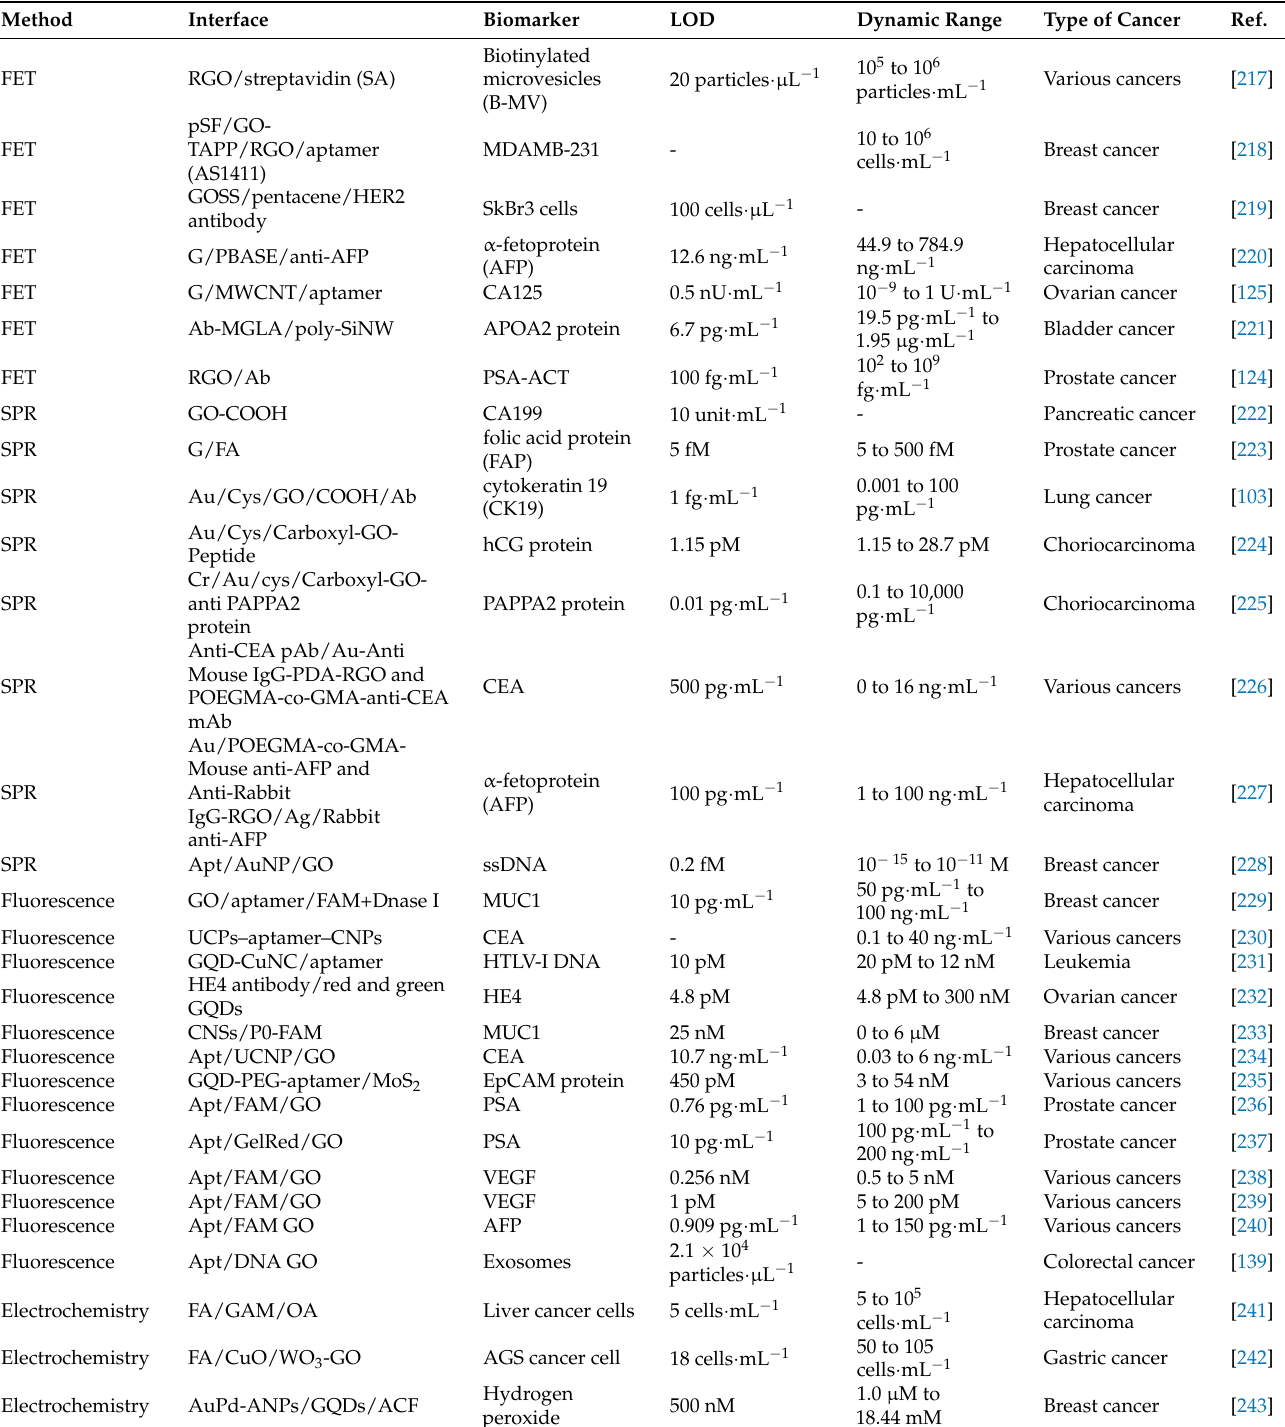
Table 2. Comparison of different cancer biomarkers detection